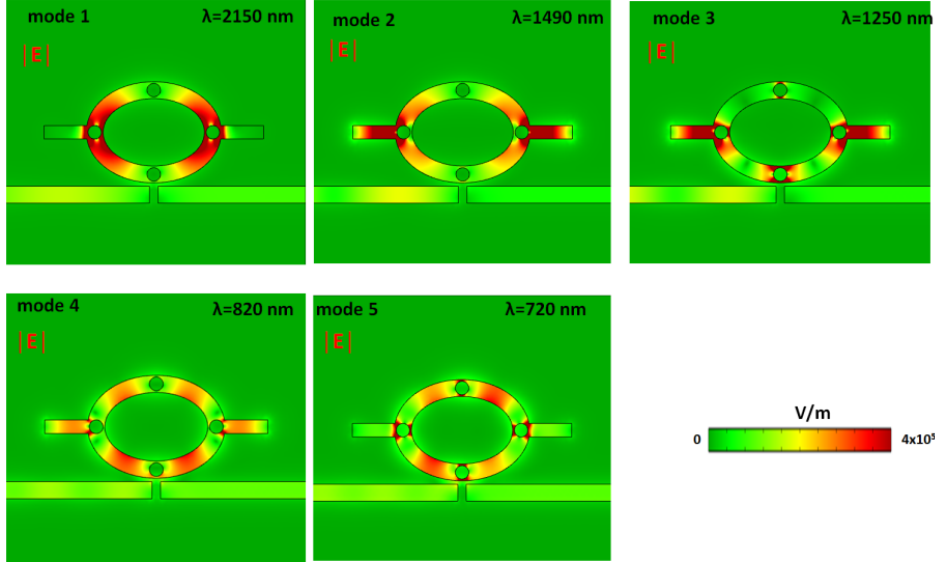
Figure 9. Electric field (E-field) intensities of case 4 structure at corresponding λ res of modes 1 – 5.